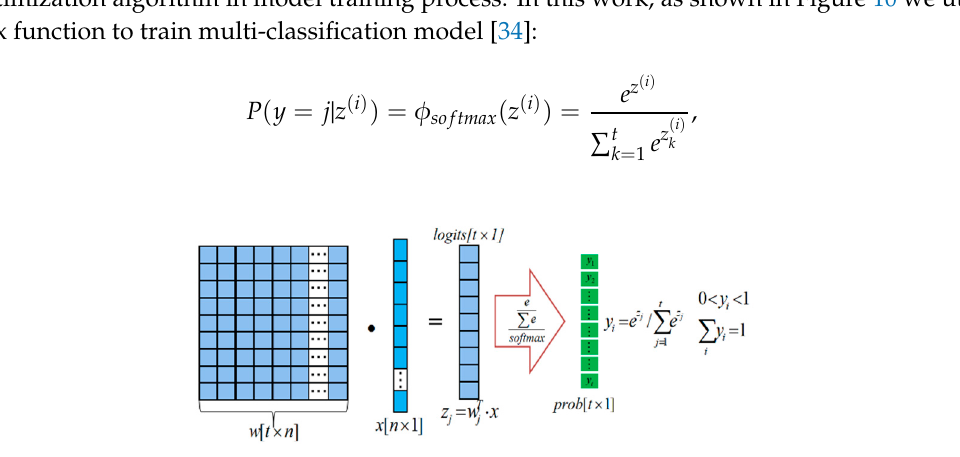
Figure 10. The system multi ‐ classification method for different defects types in training and testing process.